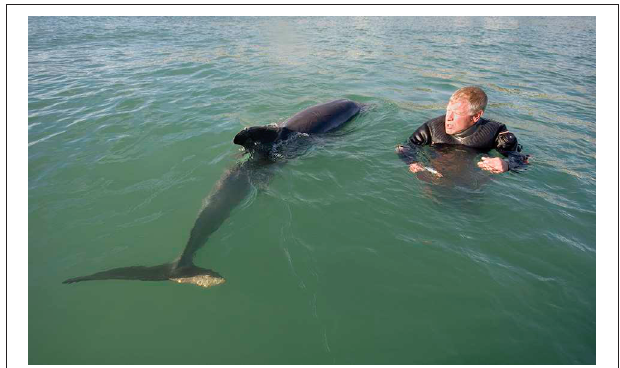
FIGURE 4 | After “Dave” received a severe wound to her tail, attempts were made to give her fish laced with antibiotics (Photo: Terry